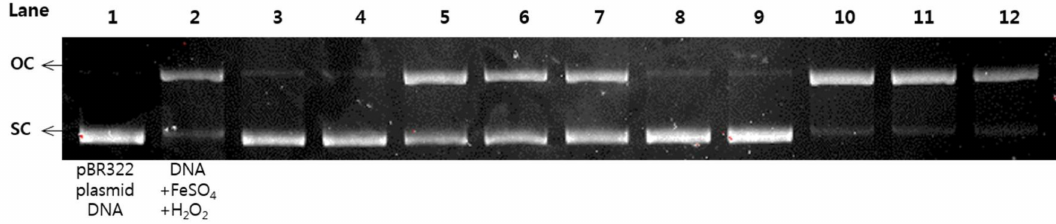
Figure 6. Protective effects of metabolites ( 10 – 18 ) against pBR322 DNA cleavage induced by hydroxyl radical oxidative injury. Lane 1: pBR322 plasmid DNA control; lane 2: pBR322 DNA + 1 mM FeSO 4 + 30% H 2 O 2 ; lane 3: compound 10 , 60 µ M; lane 4: compound 11 , 60 µ M; lane 5: compound 12 , 60 µ M; lane 6: compound 13 , 60 µ M; lane 7: compound 14 , 60 µ M; lane 8: compound 15 ,